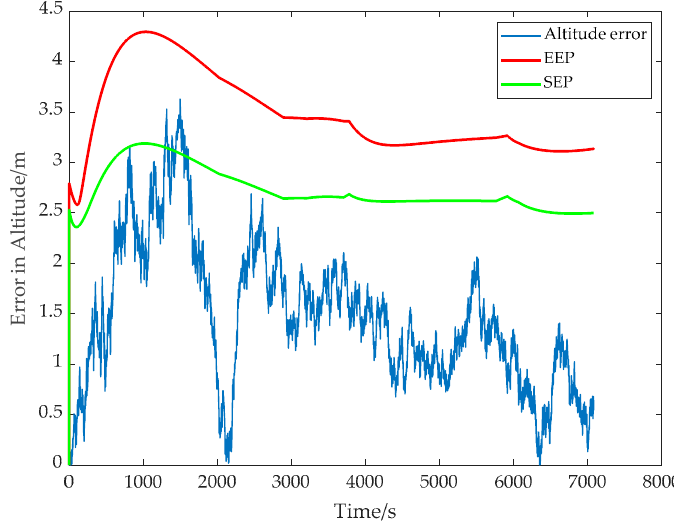
Figure 14. Comparison between latitude position error and ANP.